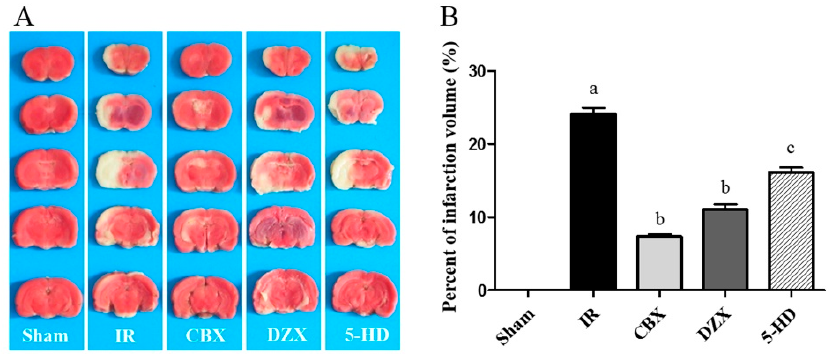
Figure 1. Effect of the mitochondrial ATP-sensitive potassium (mitoKATP) channel on infarction volume in rats with induced middle cerebral artery occlusion (MCAO). ( A ) 2,3,5-triphenyltetrazolim chloride staining of rat brains after 2 h of middle cerebral artery occlusion and 12 h reperfusion; ( B ) The percent of cerebral infarct volume in rats. Data are presented as mean ± standard deviation, n = 3 in each group. F = 243.3, p ≤ 0.05; a p ≤ 0.01 vs. Sham; b p ≤ 0.01 vs. IR; c p ≤ 0.05 vs. DZX. 5-HD: 5-hydroxydecanoic acid; CBX: carbenoxolone; DZX: diazoxide; IR: ischemia-reperfusion.